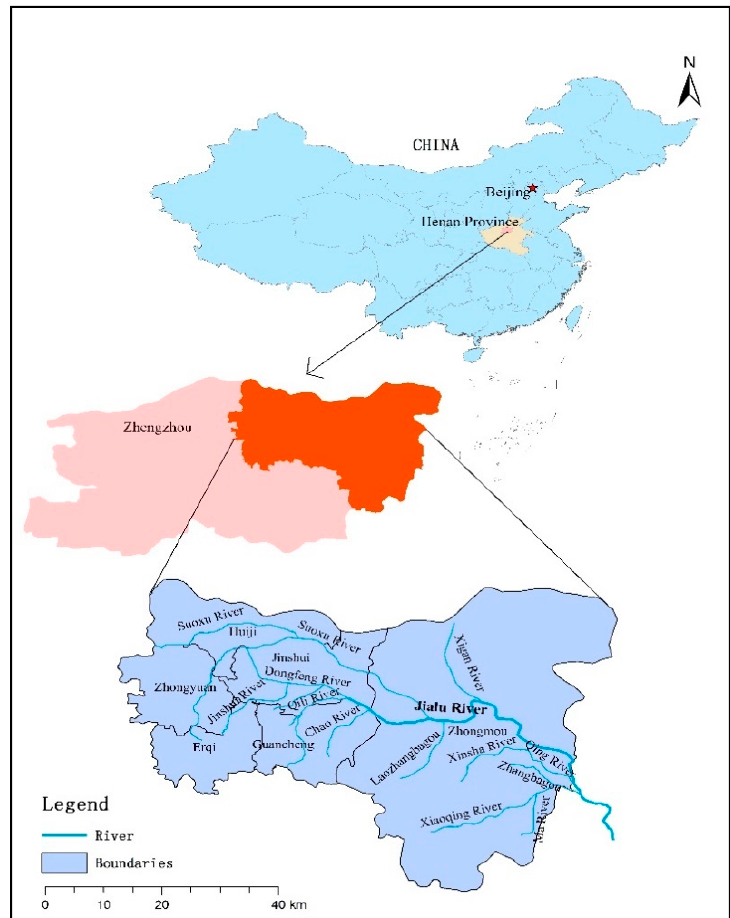
Figure 1. Drainage map of the Jialu River in Zhengzhou.